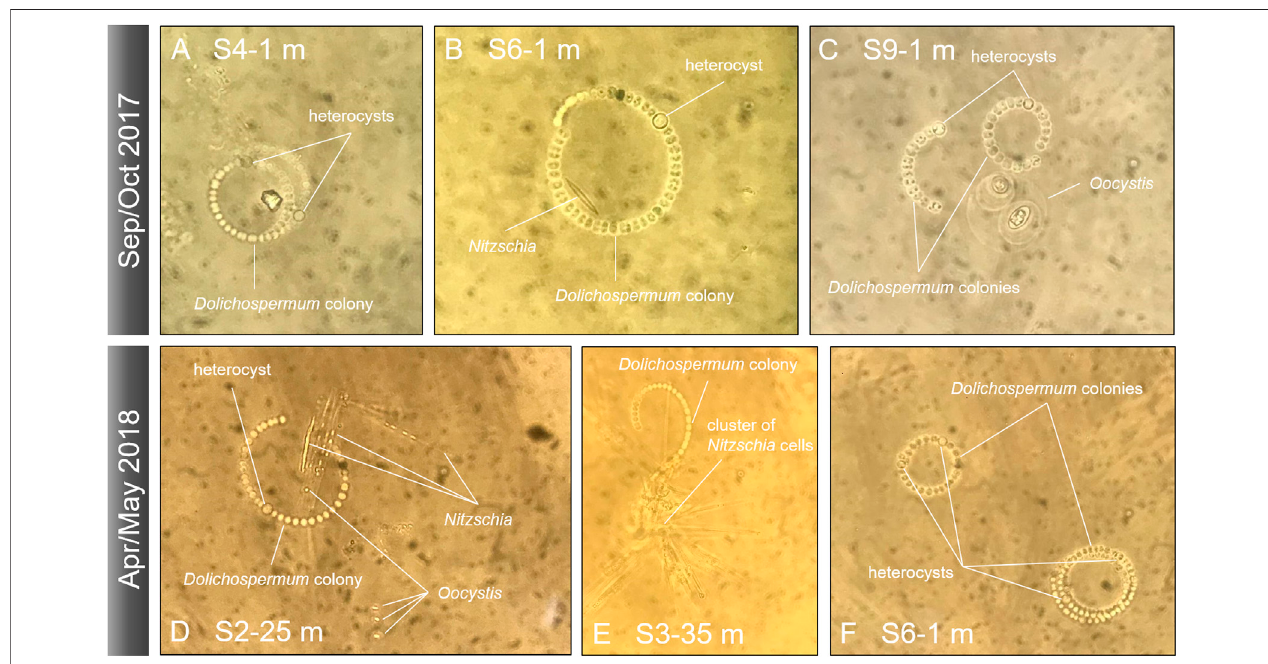
FIGURE 8 | Microscopic images of Dolichospermum colonies with heterocysts and potential associations with other taxa at various sites during September/ October 2017 (top) and April/May 2018 (bottom) . Panels (A, F) show Dolichospermum colonies in the absence of other taxa. Panels (B,C) depict Nitzschia and Oocystis cells in close vicinity of Dolichospermum colonies, whereas (D,E) reveal clusters of Nitzschia apparently being entangled in Dolichospermum colonies.